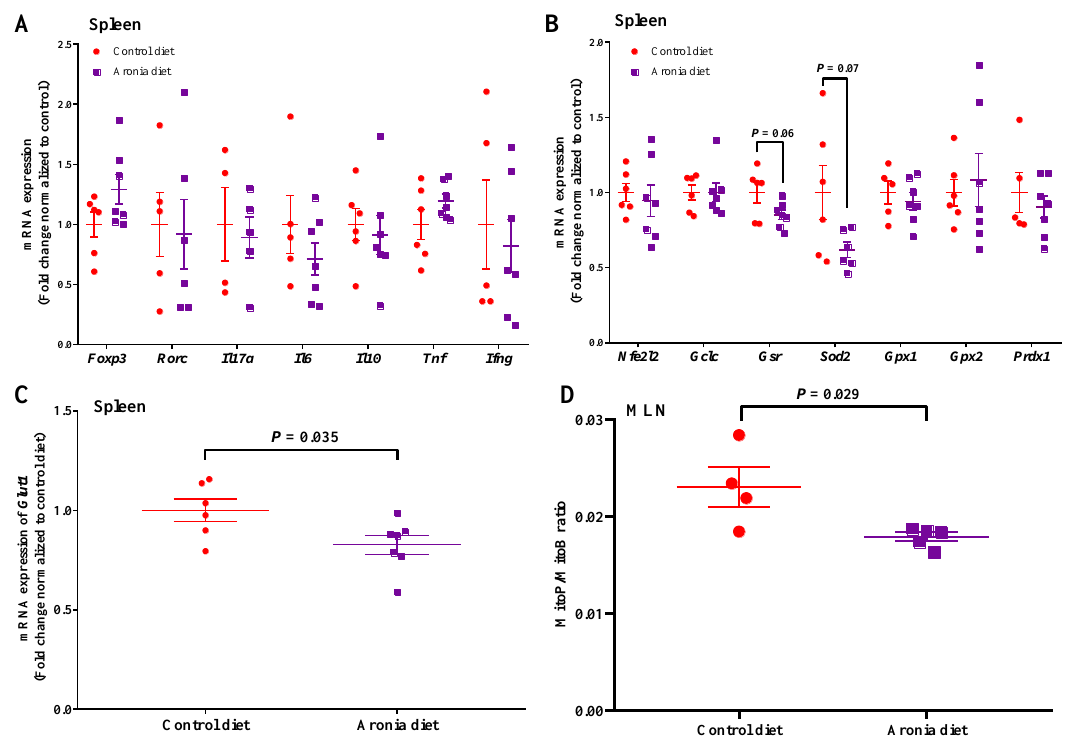
Figure 7. Aronia consumption decreases mitochondria H 2 O 2 in MLN but does not a ff ect the expression of antioxidant enzymes and cytokines in the spleen. C57BL / 6J mice consumed the AIN-93M diet or aronia-supplemented diet for five weeks. ( A ) The mRNA expressions of transcription factors of Foxp3 (forkhead box P3) and Rorc (RAR-related orphan receptor gamma), and cytokines of Il17a (interleukin 17A), Il6 (interleukin 6), Il10 (interleukin 10), Ifng (interferon- γ ), and Tnf (tumor necrosis factors) in the spleen ( n = 5–7 / group). ( B ) The mRNA expressions of transcription factor of Nfe 2l2 (erythroid-derived 2-like 2) and the downstream antioxidant enzymes of Gclc (glutamate-cysteine ligase-catalytic subunit), Gsr (glutathione reductase), Sod2 (superoxide dismutase 2), Gpx1 (glutathione peroxidase 1), Gpx2 (glutathione peroxidase 2), and Prdx1 (peroxiredoxin 1) in the spleen ( n = 6–7 / group). ( C ) The mRNA expressions of Glut1 (glucose transporter 1) in the spleen ( n = 6–7 / group). ( D ) MitoP / MitoB ratio in mesenteric lymph node (MLN) ( n = 4–5 / group). The mRNA expressions (normalized to Eef2 (eukaryotic translation elongation factor 2) and Rplp0 (ribosomal protein large P0)). Data are means ± SEMs.